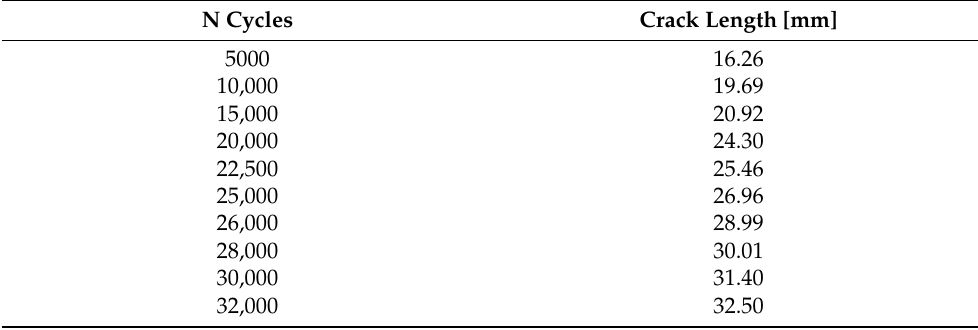
Table 1. Experimental target crack length measured at different fatigue load cycles. N